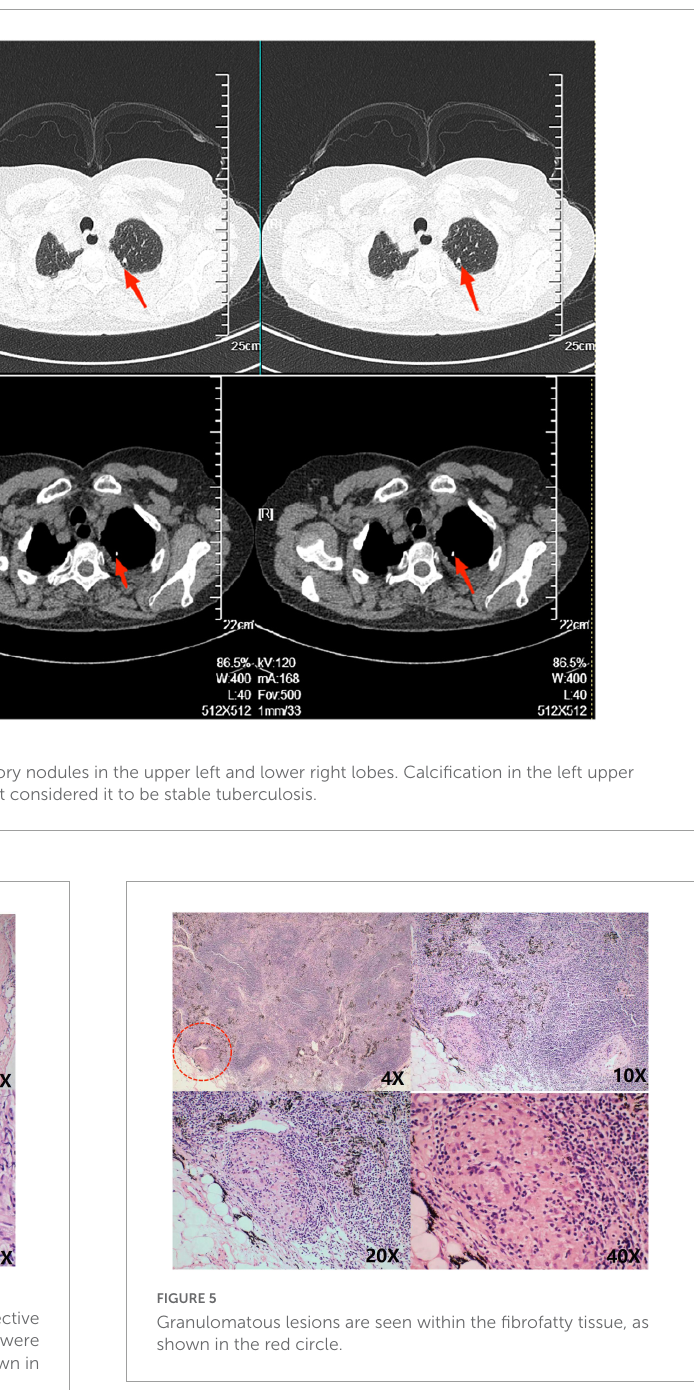
32 U/L in the pericardial fluid, and negative results for the culture of antacid bacilli in the pericardial fluid, which do not form the basis for a TBP diagnosis. A meta-analysis found the overall sensitivity and specificity of interferon-gamma (IFN- γ ) to be 97 and 99%, respectively. However, IFN- γ is relatively expensive and is not commonly used as a laboratory test (16).